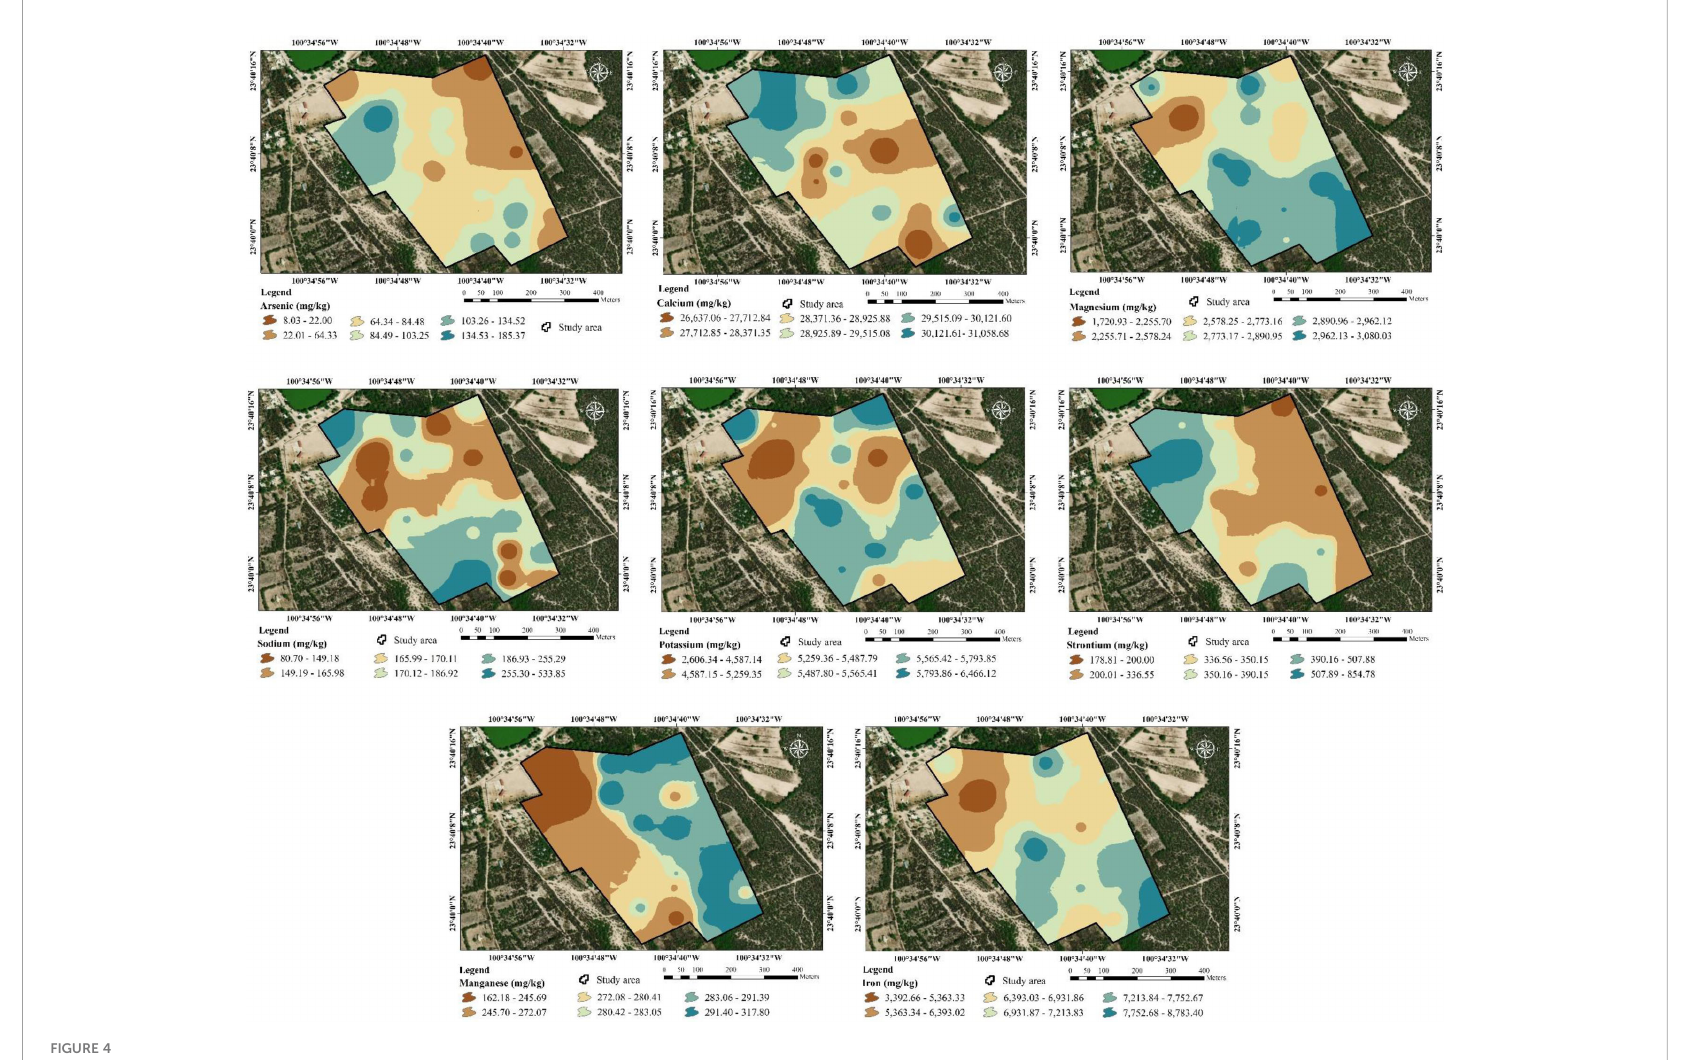
FIGURE 4 Spatial distribution of metal concentrations in the agricultural